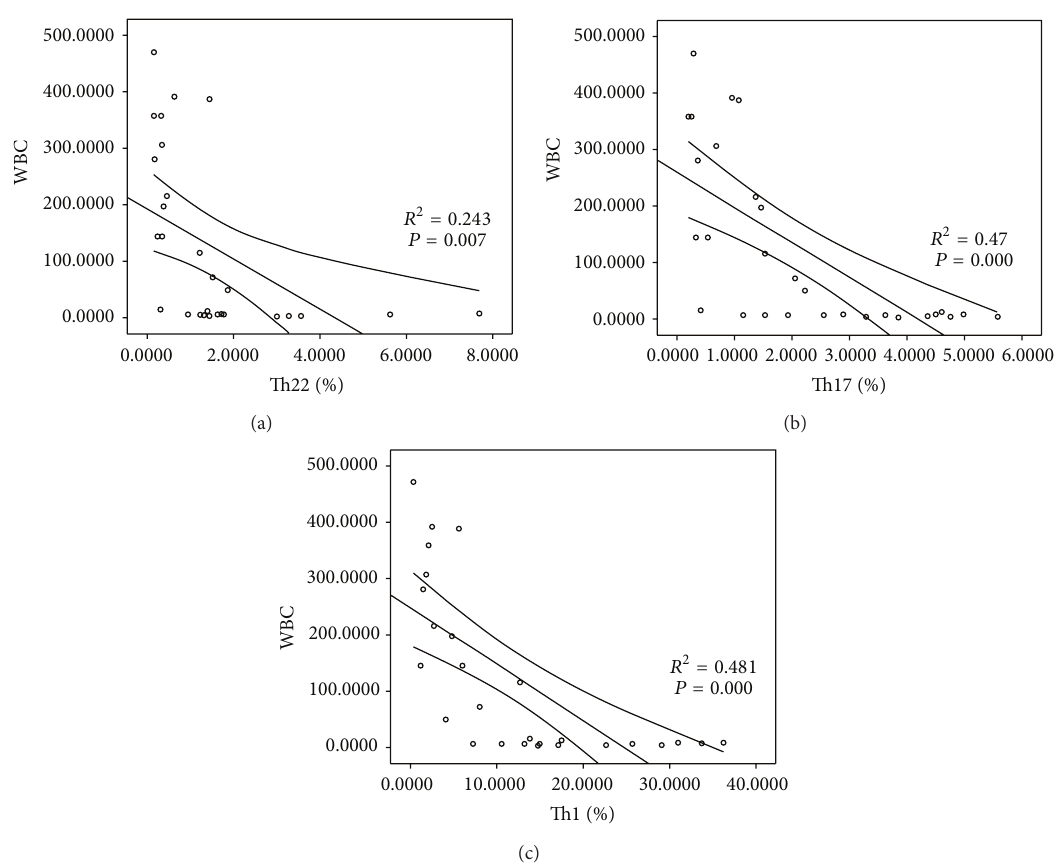
Figure 6: Clinical relevance between the frequencies of Th22, Th17, and Th1 cells and peripheral white blood cell number in CML patients. (a) Negative correlation was found in Th22 cell and peripheral white blood cell number. (b) Negative correlation was found in Th17 cell and peripheral white blood cell number. (c) Negative correlation was found in Th1 cell and peripheral white blood cell